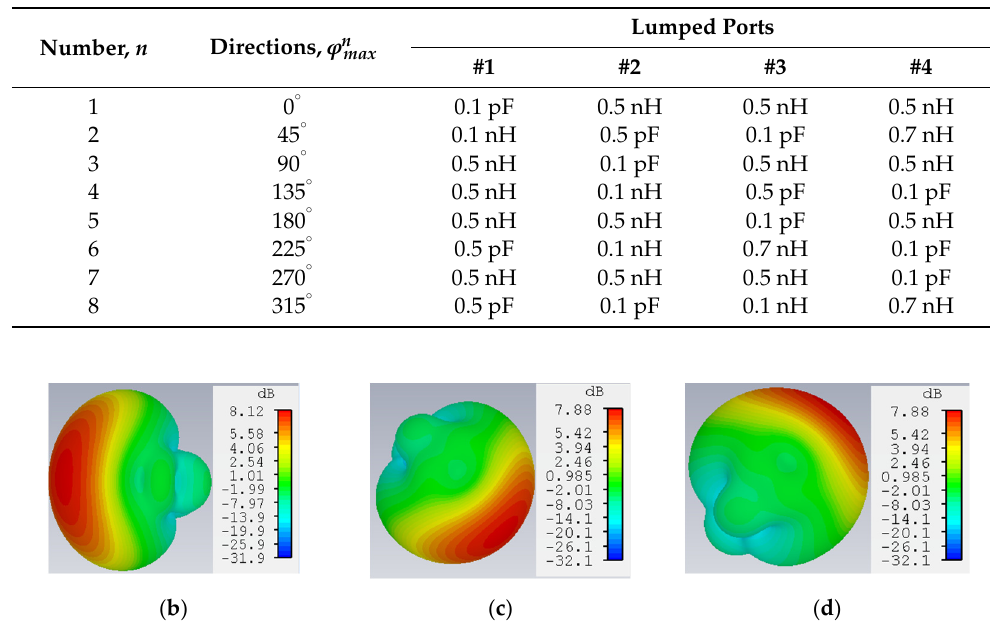
Table 2. Reactance set of the single ESPAR antenna.